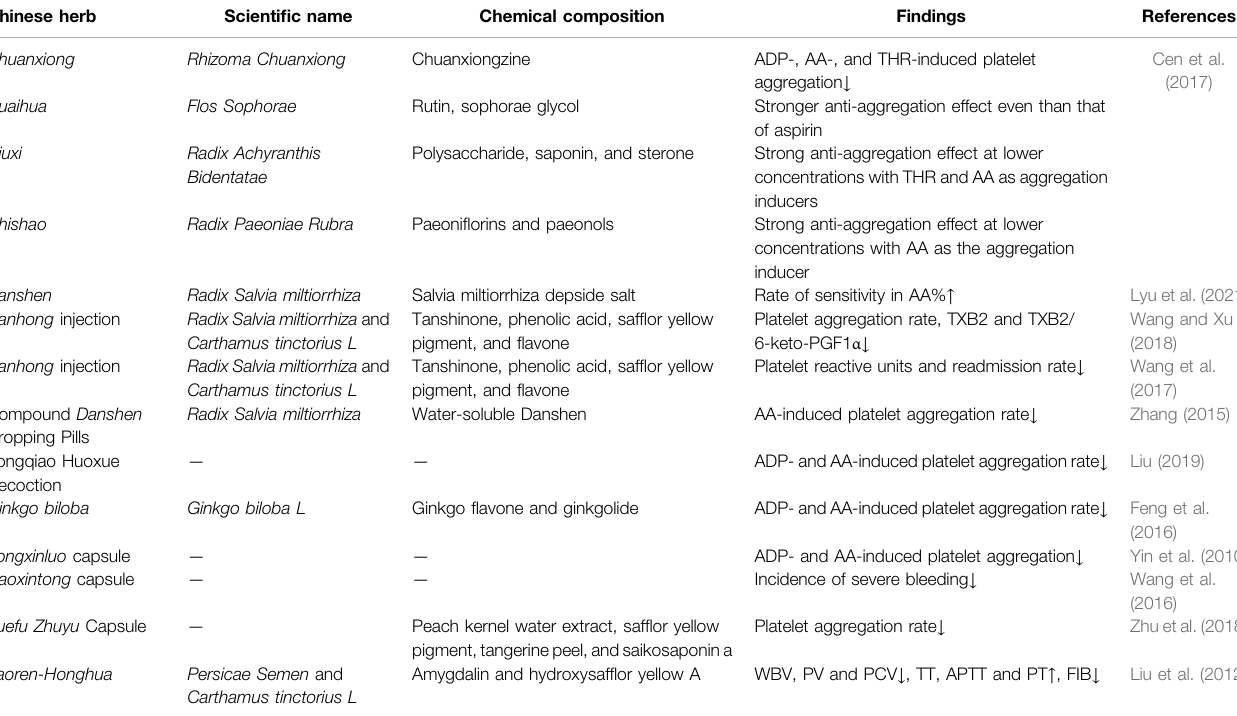
TABLE 2 | Research studies on Chinese herbs that have been tested for aspirin